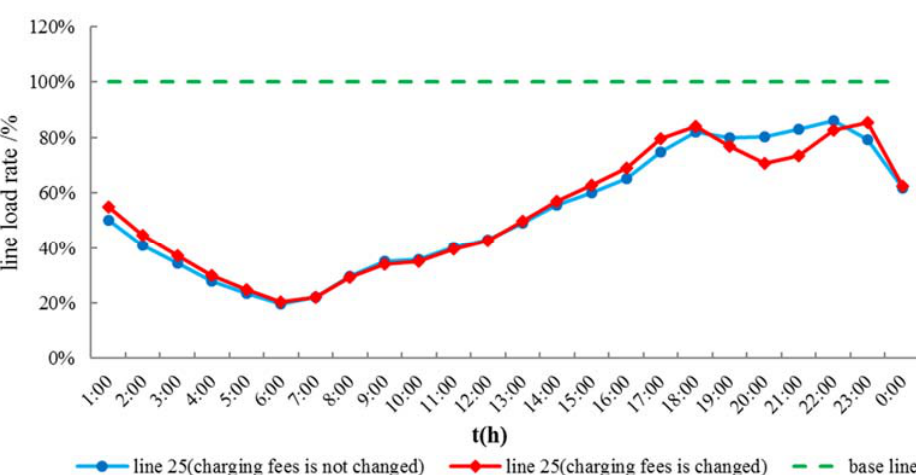
Figure A4. Line load rate of line 5 before and after adjustment for charging fees.